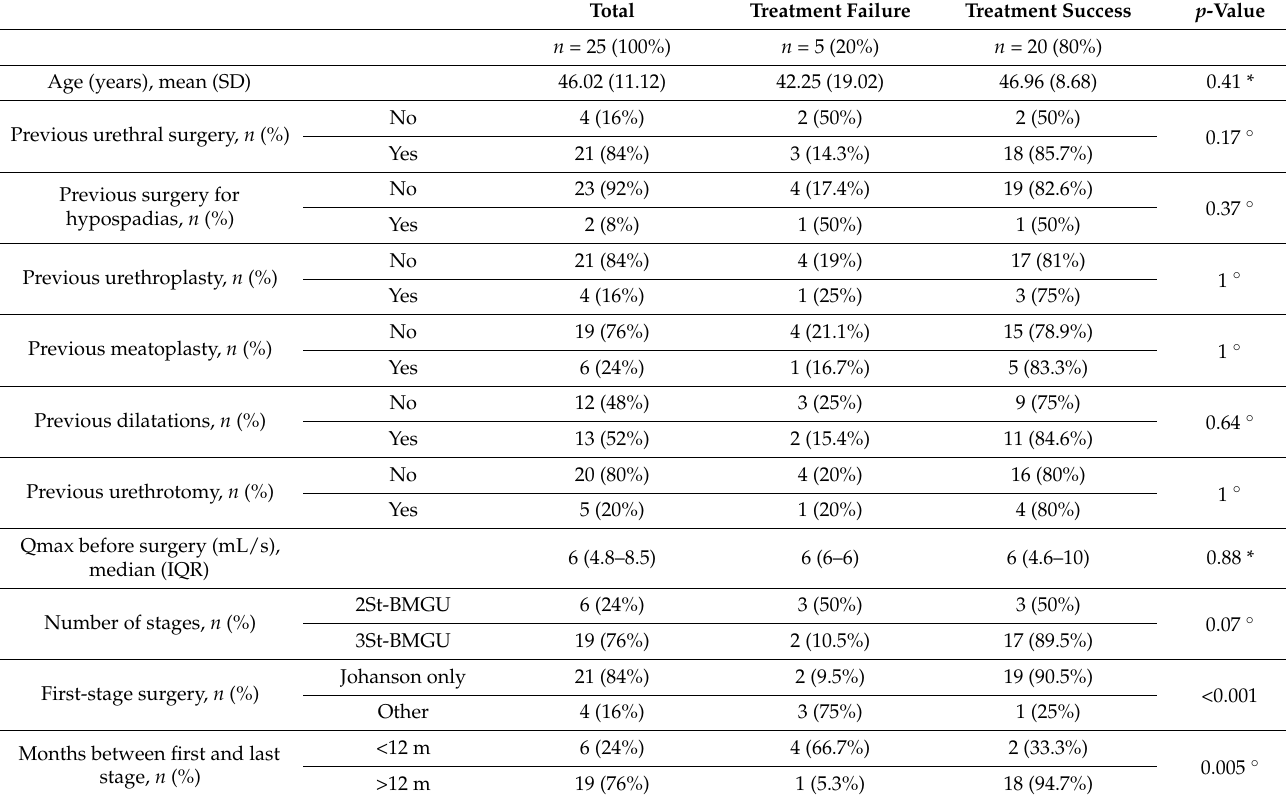
Table 2. Main characteristics of the population with available follow-up.